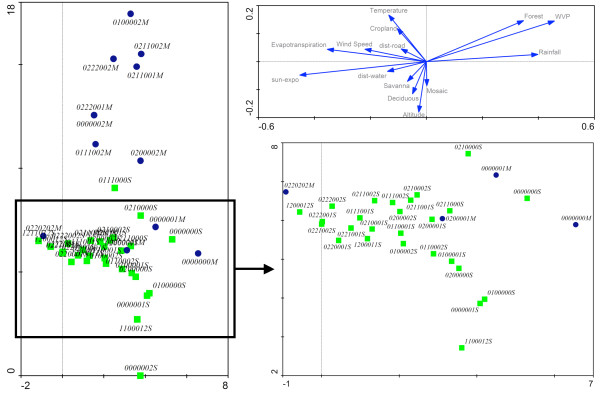
Distribution in multivariate ordination space of chromosome-2 karyotypes of the An. gambiae molecular forms. Detrended Correspondence Analysis (DCA) of chromosome-2 karyotypes in the M (blue circles) and S (green squares) molecular forms of An. gambiae on the first two ordination axes. Karyotypes are encoded according to the sequence of inversions on chromosome-2, each digit corresponding to the observed karyotype for inversions 2Rj,b,c,d,u,k and 2La, respectively. Eco-geographical variables (EGVs, see Methods) are passively plotted (unconstrained analysis) in the upper-right diagram to show how they correlate with the two ordination axes. For visualization clarity, only EGVs with significant scores are shown. The lower-right diagram zooms in to show the crowded central part of the main diagram on the left. All three diagrams are intended to be part of the same plot, and are here separated only for visualization purposes. WVP: Water Vapour Pressure; sun-expo: Sunlight exposure; dist-road: Distance to roads; dist-water: Distance to water bodies; Deciduous: Deciduous woodland; Mosaic: Forest-savanna mosaic.